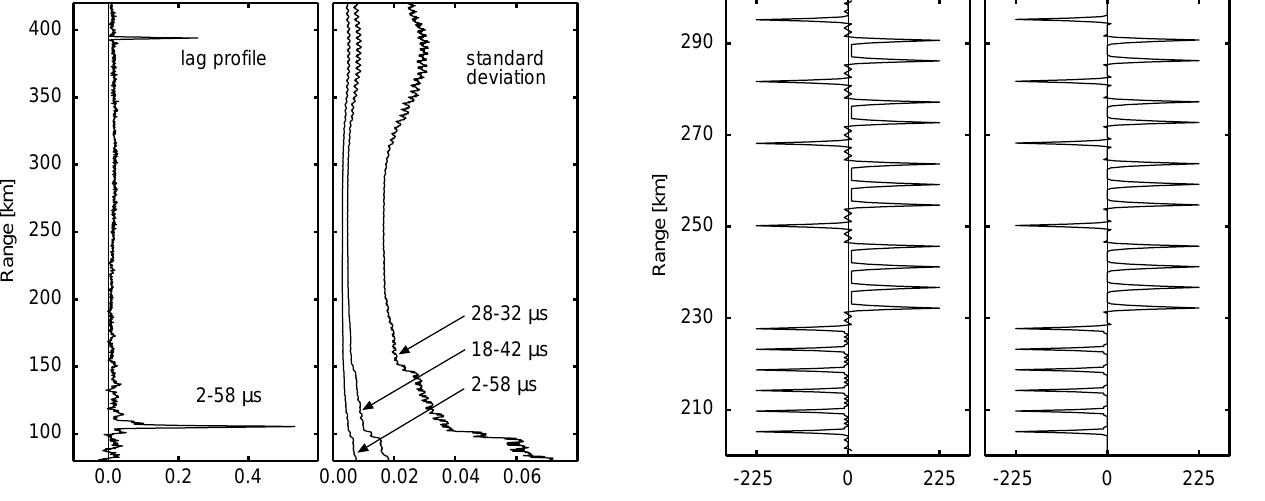
Fig. 6. Left: An estimate of the profile of the 30- µ s lag σ (k) tained by inversion of lag profiles 2–58 µ s. Right: A posteriori standard deviations of inversion results for different sets of mea- sured lag profiles, which are included in the inversion.